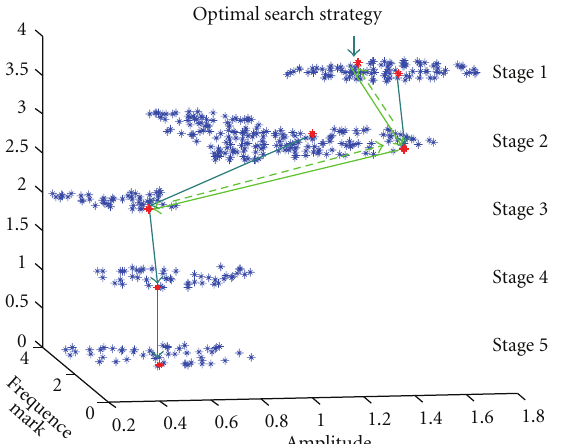
Figure 13: Presentation of Optimal search strategy with error event signals (backward